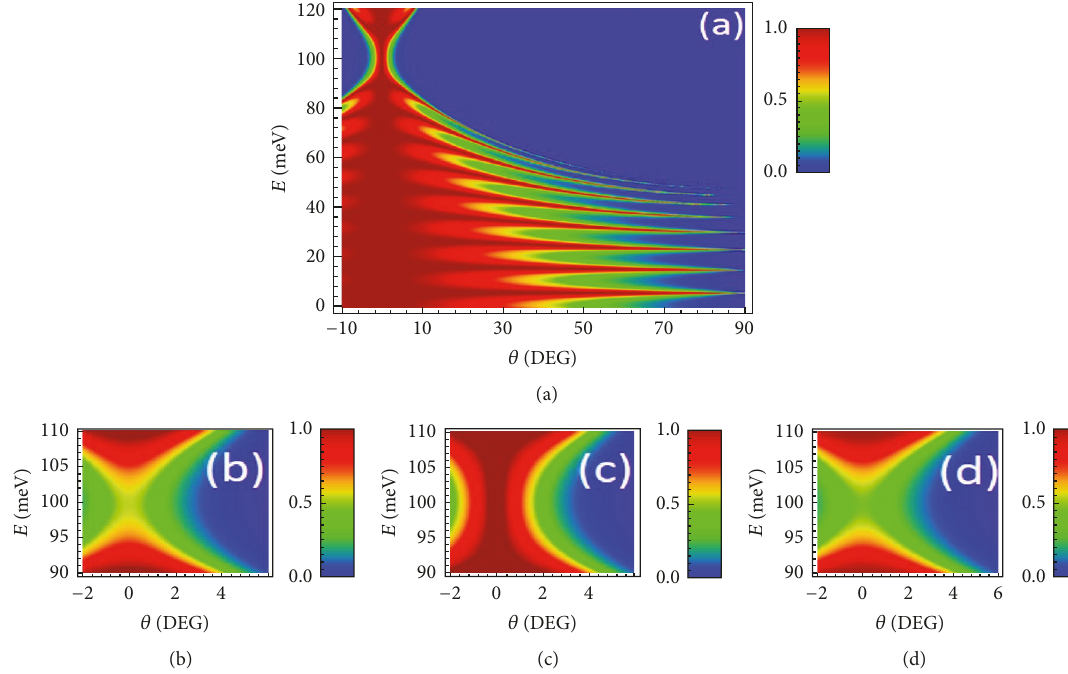
Figure 2: (Color online) (a) (𝐸,𝜃) contour plot of the transmission through a single barrier for spin-up electrons. The width and height of the barrier are 𝑊 = 110 nm and 𝑈 = 100 meV, respectively, the field 𝐸 𝑧 = 170 meV/nm, and V 𝐹 = 5.5 × 10 5 m/s. Panels (b), (c), and (d) show the region (𝐸,𝜃) delimited by −2 ≤ 𝜃 ≤ 6 and 90 ≤ 𝐸 ≤ 110 meV and correspond, respectively, to 𝐸 𝑧 = 50 , 170 , and 300 meV/nm.